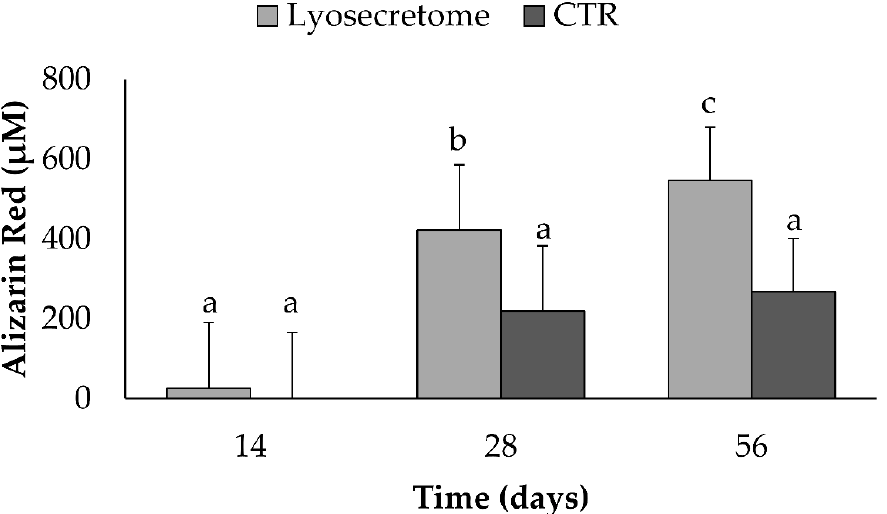
Figure 7. Alizarin red staining for samples cultured in osteogenic differentiation medium with Lyosecretome or without (CTR) for 14, 28, and 56 days. Multifactor ANOVA (time and treatment, mean values ± LSD, n = 3) was used. Both time and treatment were significant ( p < 0.0001 and p = 0.0142, respectively). Different letters indicate a significant difference between the means ( p < 0.05), while the same letters indicate no significant difference between the means ( p > 0.05).